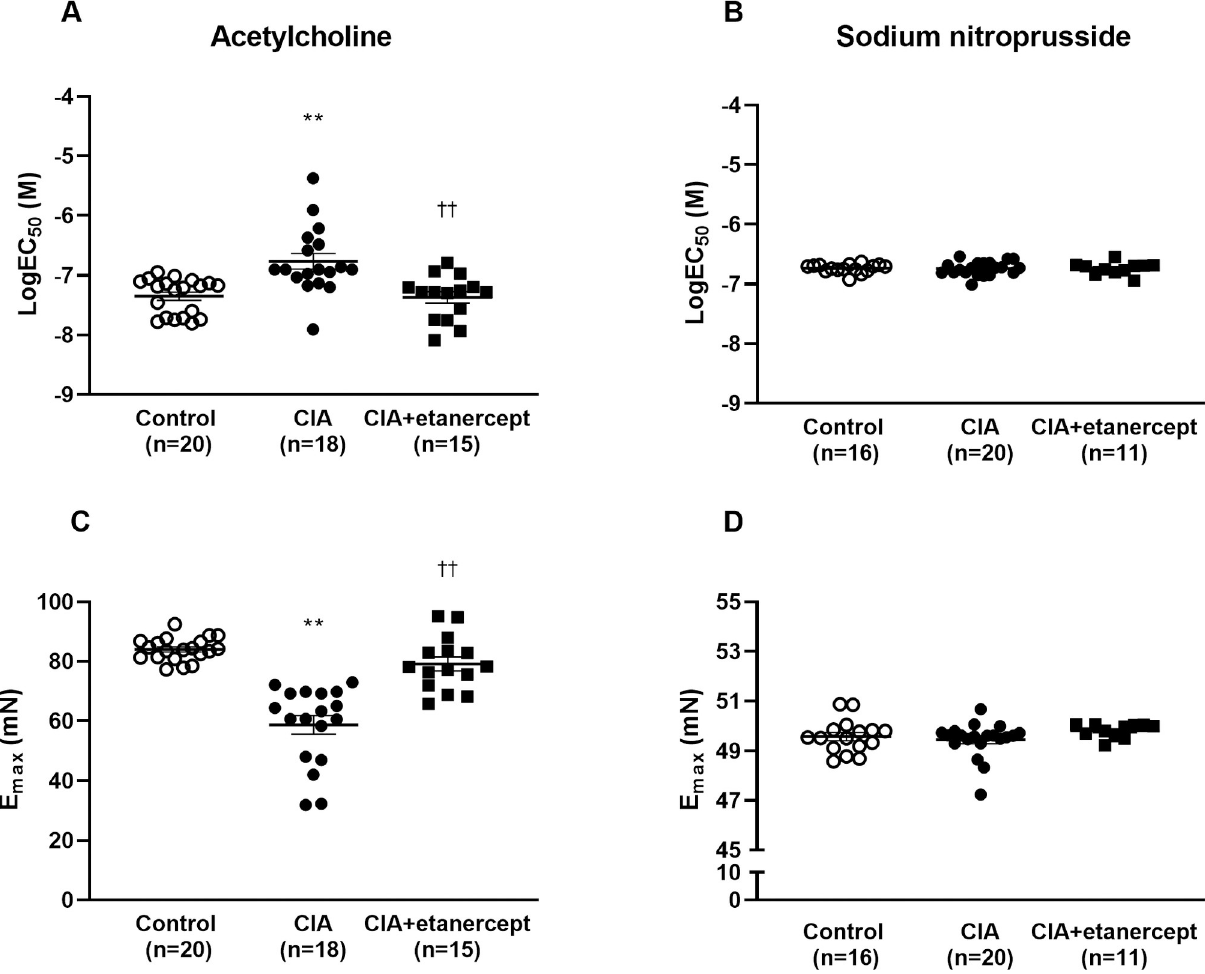
Fig 3. The effects of TNF- α inhibitor treatment on the sensitivity (LogEC 50 ) and maximum responses (E max ) to vasodilatory substances in mesenteric arteries. The sensitivity (LogEC 50 ) to acetylcholine (A) and sodium nitroprusside (B) and the maximal relaxation response (E max ) to acetylcholine (C) and sodium nitroprusside (D) in the second branch of mesenteric arteries, in control, CIA and CIA+etanercept groups. Data expressed as means ± SEM. �� p < 0.001 versus control; †† p < 0.001 versus CIA; using two-way ANOVA and Tukey post-hoc